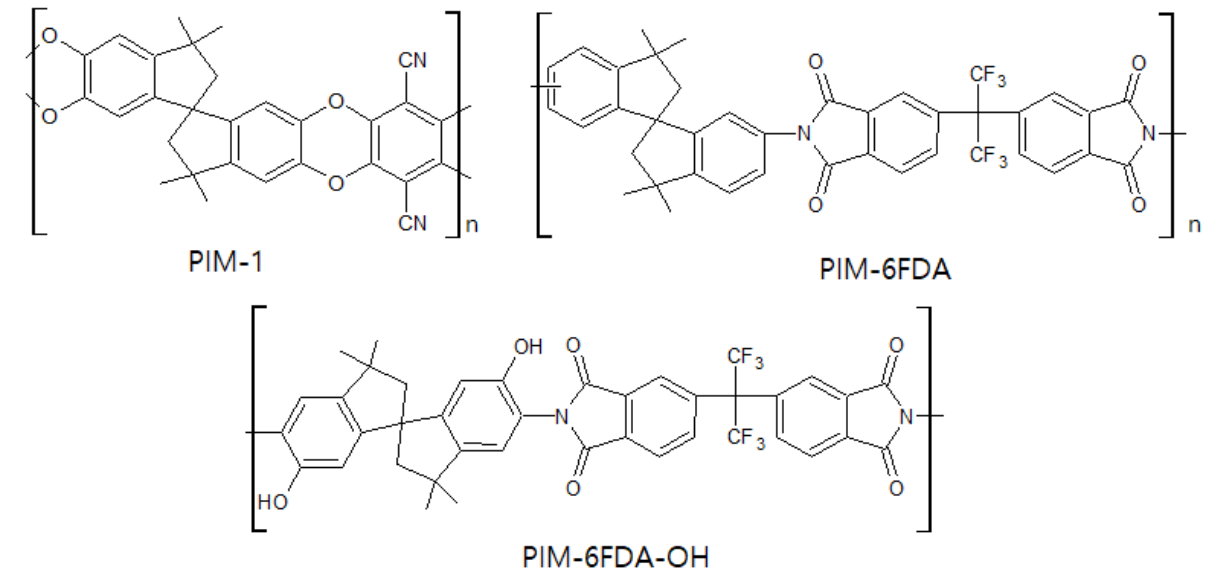
Figure 12. Chemical structures of PIM-based polymer precursors.